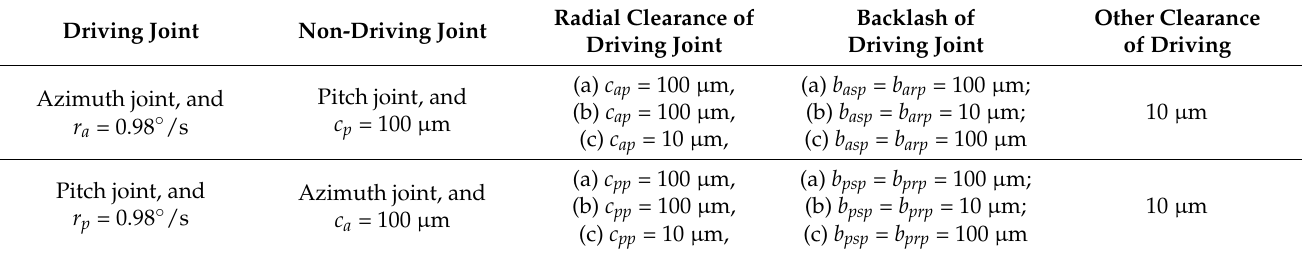
Table 7. Simulation parameters of coupling between radial clearance and